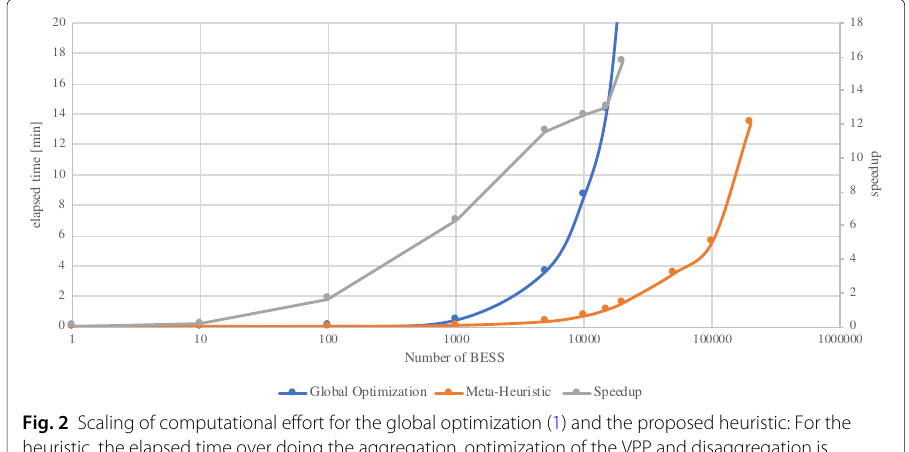
Fig. 2 Scaling of computational effort for the global optimization (1) and the proposed heuristic: For the heuristic, the elapsed time over doing the aggregation, optimization of the VPP and disaggregation is measured and shown. In Algorithm 3 these are lines 2 - 4. For the global optimization, only the time used for solving the linear problem is measured. Further, the speedup of the heuristic relative to the global optimization is depicted. All values are shown for increasing number of BESS from one up to 200,000 BESS. As long as there is enough memory available, the effort of both algorithms does not increase exponentially (note the logarithmic scale of the x-axis). Nevertheless, the heuristic provides already a speed-up of more than 10 and allows at least the consideration of 100,000 BESS giving a time frame of maximally 15 min whereas the global optimization can handle only 15,000 BESS. Note that the implementation of the heuristic did not even exploited the use of